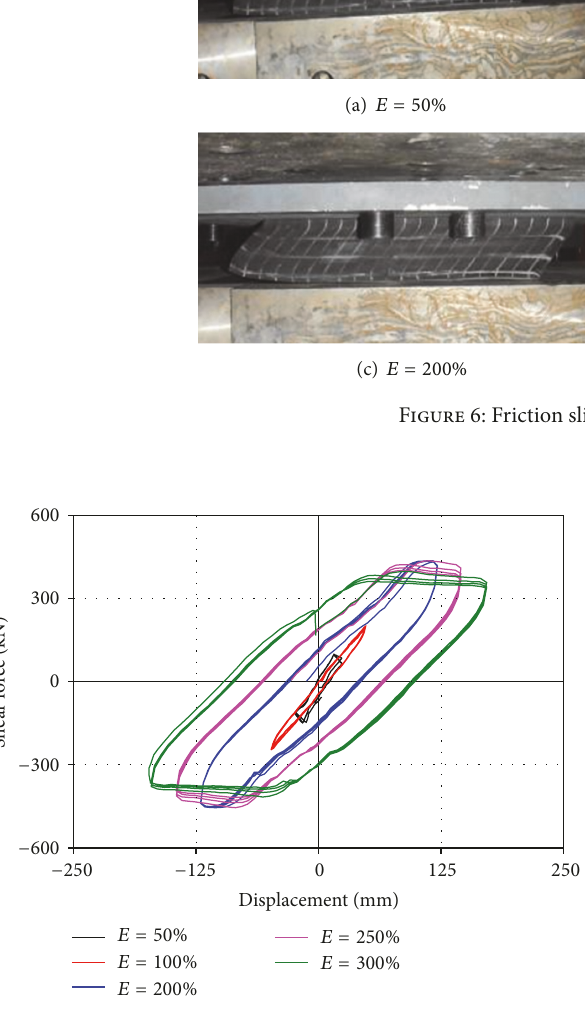
Figure 7: The hysteresis curve of the bearing sliding friction (M-2).